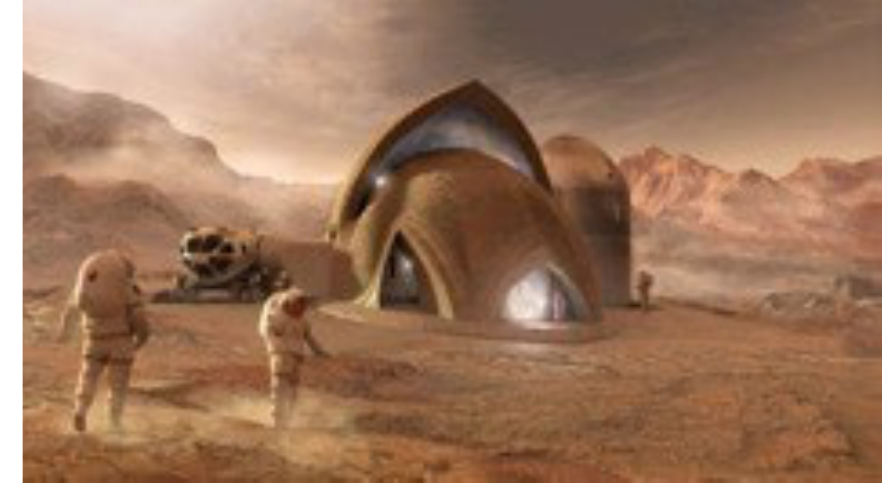
Figure 6. The Mars Habitat project [28].